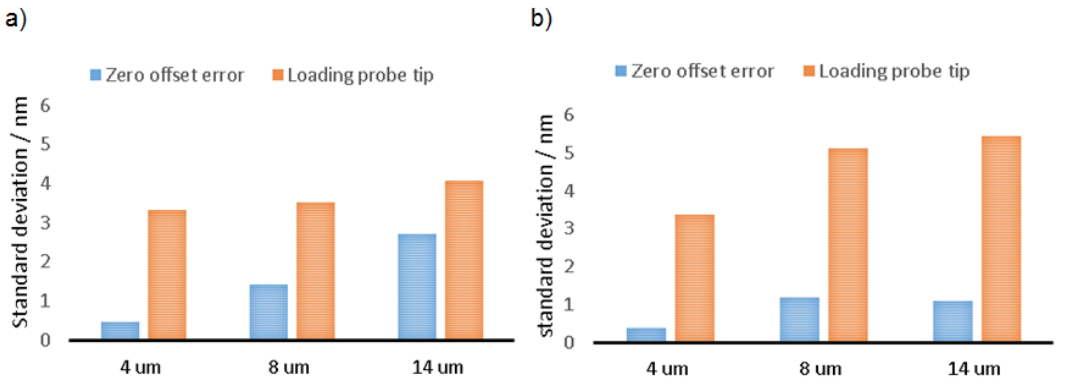
Figure 11. Bar charts showing repeatability in stiff mode for three nominal displacements (4 µ m, 8 µ m and 14 µ m). ( a ) Shows results for the z direction; ( b ) shows results for the y